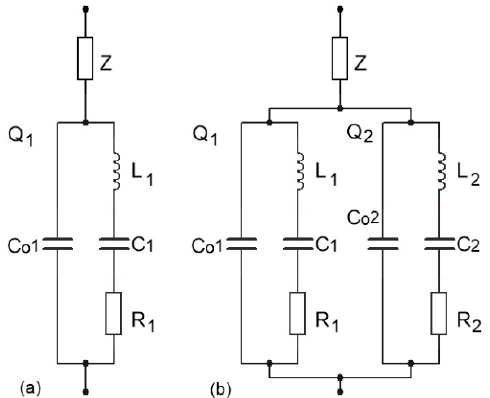
Figure 2. ( a ) Equivalent single-quartz crystal electrical circuit and ( b ) additional connection of a second crystal in parallel to the first one. In both cases, the same impedance Z is connected in series. The frequency ratio Ω = ω / ω o is determined near the crystal’s (Q 1 ) serial resonance frequency, where 𝜔 (cid:2868) = 1 (cid:3493)𝐿 (cid:2869) ∙ 𝐶 (cid:2869) ⁄